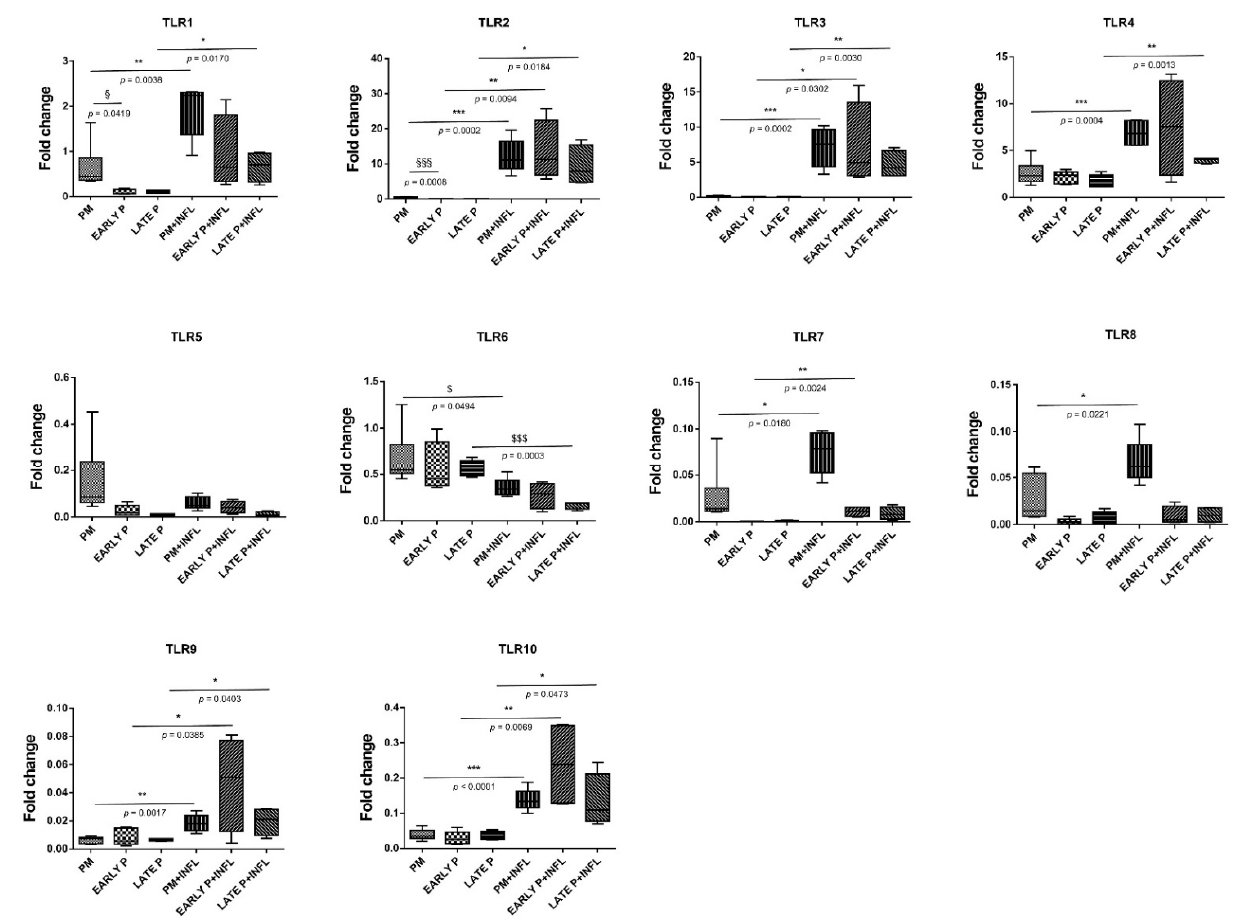
Figure 6. Distinct expression of Toll-like receptor (TLRs) and differential regulation in MSCs. The gene expression level of each cytokine is determined by qPCR analysis from basic MSCs and inflamed MSCs (INFL) during the primo culture (PM), early (EARLY) and late (LATE) passage (P). The values are expressed as mean ± SEM compared to the expression of the housekeeping gene (ACTB and GAPDH). *, **, *** Significant increase of expression of inflamed MSCs (INFL) versus basic MSCs ( p -value: p ≤ 0.05, p ≤ 0.01, p ≤ 0.001, respectively). $, $$$ Significant decrease of expression of inflamed MSCs (INFL) versus basic MSCs ( p -value: p ≤ 0.05, p ≤ 0.001, respectively). §, §§§ Significantly higher expression compared to the consecutive passage ( p -value: p ≤ 0.05, p ≤ 0.001, respectively).